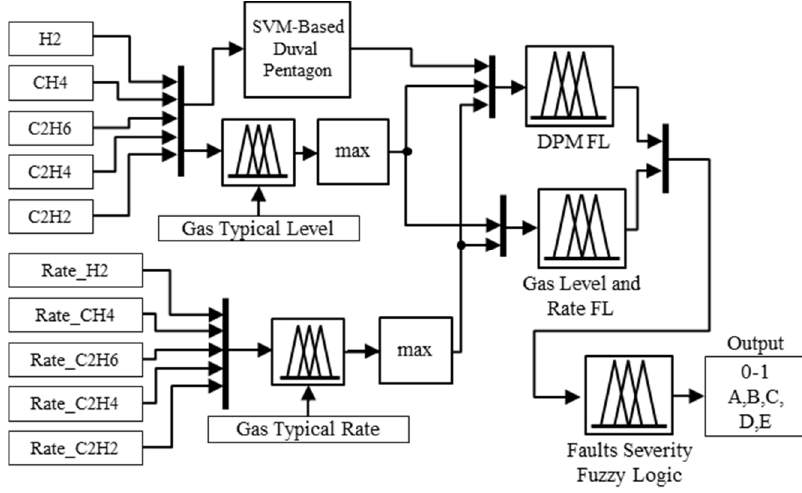
Figure 7. Faults’ severity fuzzy logic model.